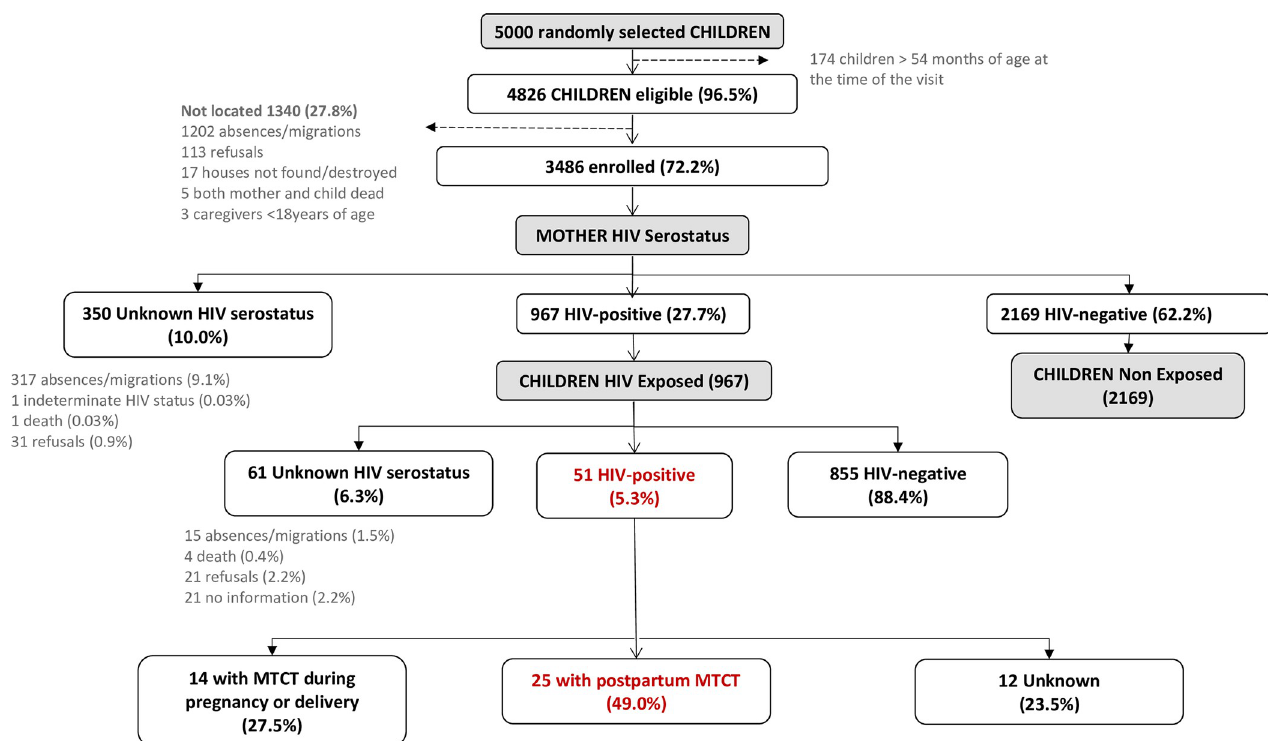
Fig 1. Study profile among the 5000 mother-child pairs randomly selected for the study. Percentages are calculated over the previous parent box. MTCT = maternal to child transmission. MTCT during pregnancy and delivery was defined as having a positive PCR result during the first 6 weeks of life. Postpartum MTCT was defined for children with an HIV positive result beyond 6 weeks of life who initiated breastfeeding if 1) they had a first negative PCR during the first 6 weeks of life, or 2) did not have a prior negative PCR but whose mother had an estimated date of infection after the child’s birth.